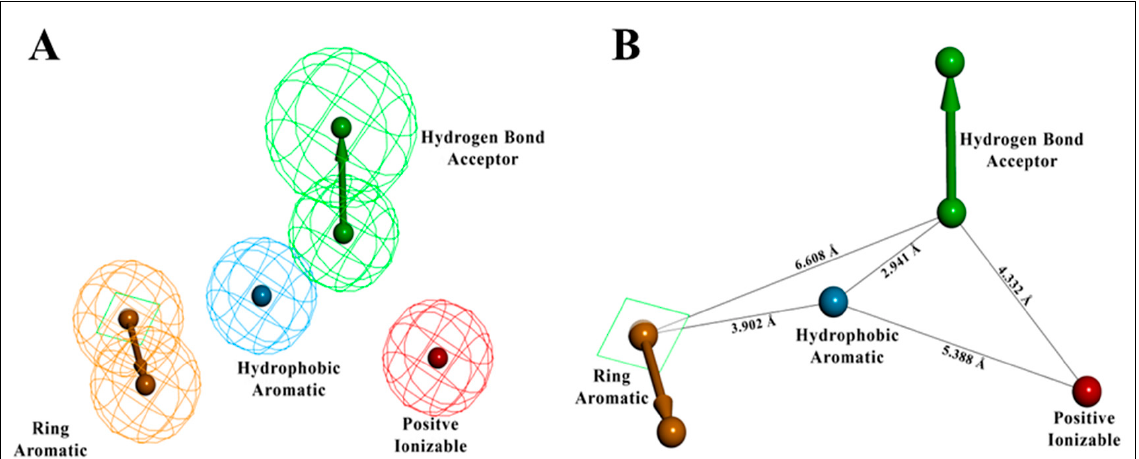
Figure 5. The best HypoGen pharmacophore model: Hypo1. ( A ) Chemical features present in Hypo1; ( B ) 3D spatial arrangement and the distance constraints between the chemical features. The green color represents HBA, the red color indicates the positive ionizable (PI) feature, the blue color represents the hydrophobic aromatic (HYA) feature, and the orange centroid represents the ring aromaticity (RA).